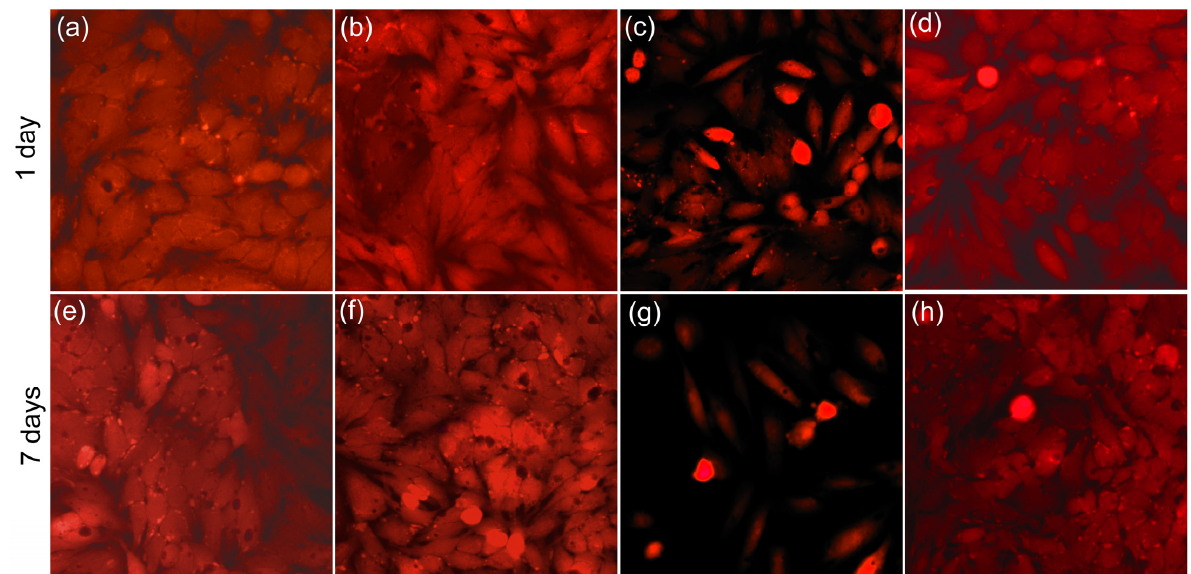
Figure 12. The morphology of the HeLa cells used as control ( a , e ); incubated with HAp nanoparticles in solution ( b , f ), incubated with Sr 2+ contaminated solutions ( c , g ), and incubated with solutions decontaminated using HAp nanoparticles ( d , h ) for 1 day and 7 days.